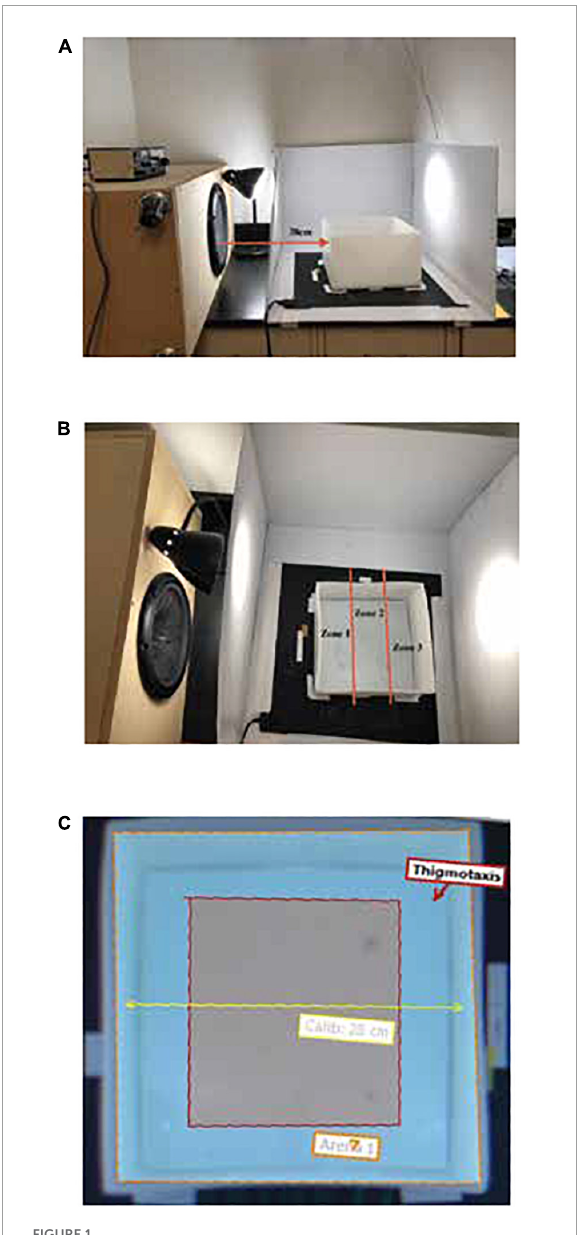
FIGURE1 Infrasound speaker placement and EthoVision XT digital zone layouts in the open field test. (A) Infrasound speaker placement of 38 cm to the left of the testing arena. (B) Location preference zones by distance from the infrasound source (Zone 1 = Speaker; Zone 2 = Middle; Zone 3 = Far). (C) Thigmotaxis zone measured 4.8 cm from the water line of each arena wall.